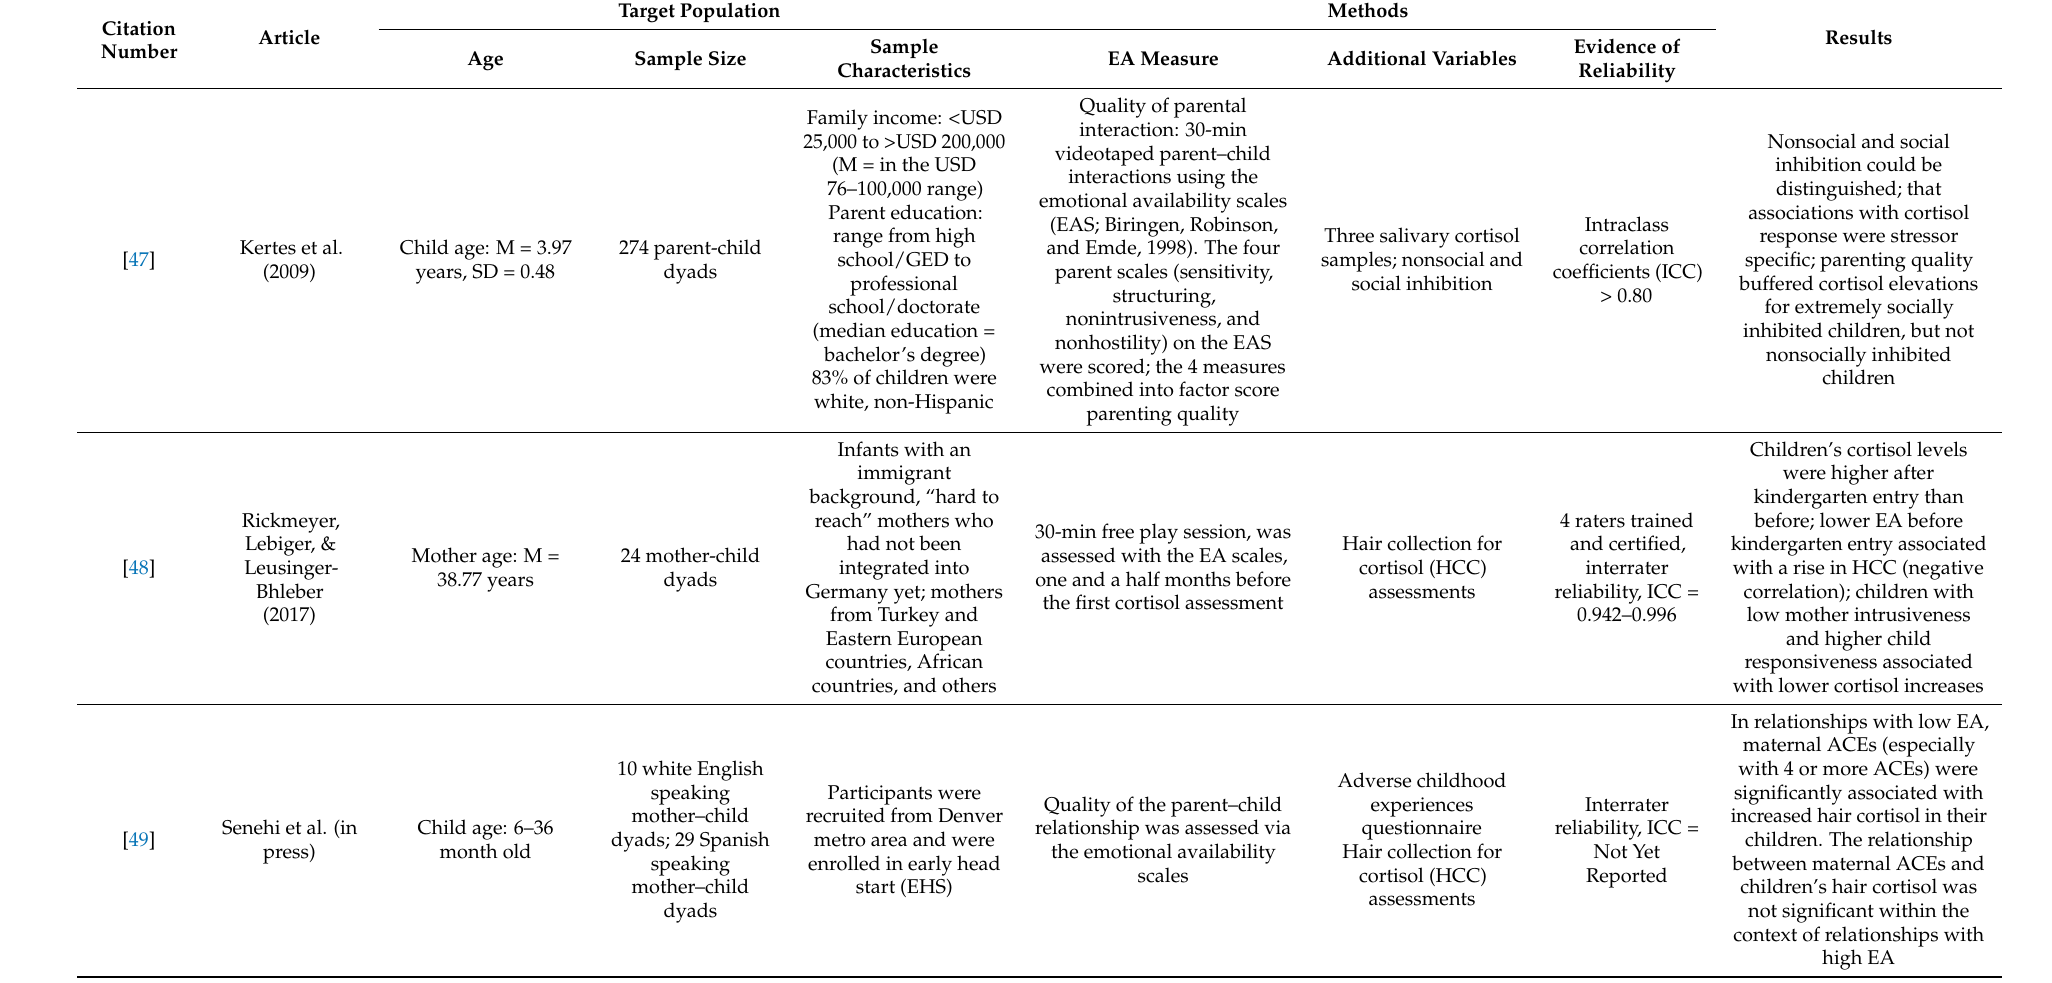
Table 1. Characteristics of studies included in the review with a stress physiology and neuroendocrine